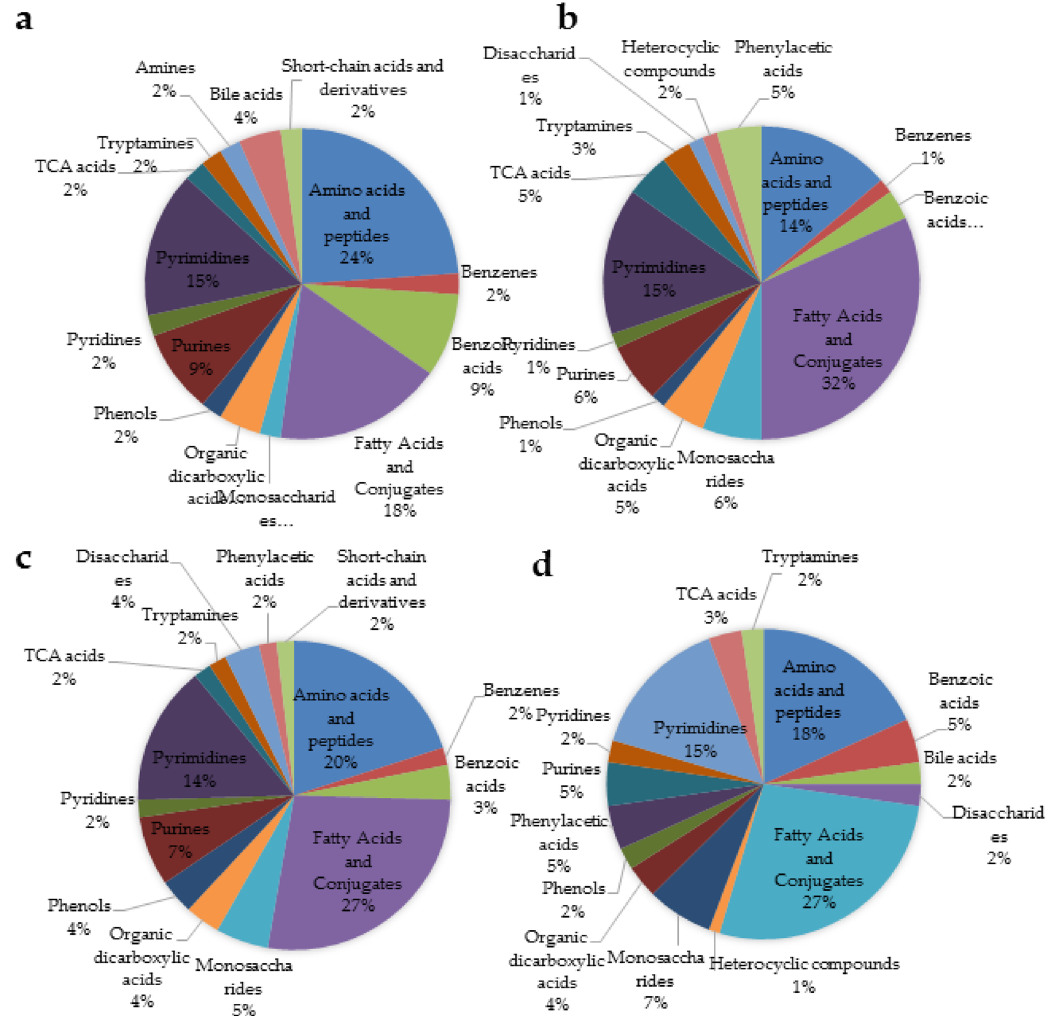
Figure 3. Pie-chart displaying the chemical specificity and biasness of metabolites extraction protocol on metabolomic profile ( a ) Sonication cycle, ( b ) Freeze–thaw cycle, ( c ) FTC + SC, ( d ) Chemical classification of all metabolites irrespective of the extraction